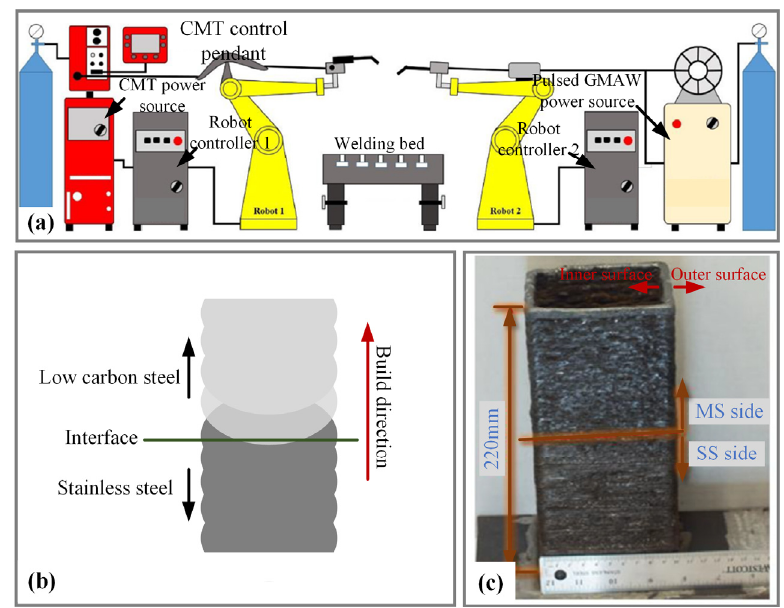
Figure 18. ( a ) Schematic of WAAM system, ( b ) Deposition path patterns [82].